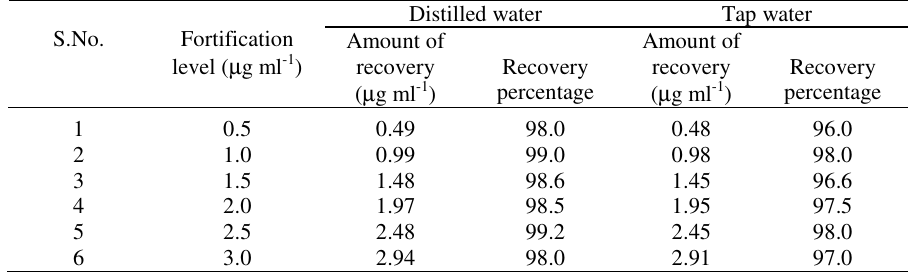
Table 6. Recovery of carbofuran from fortified water sample using diazotized 4-methylaniline as a coupling agent. S.No.